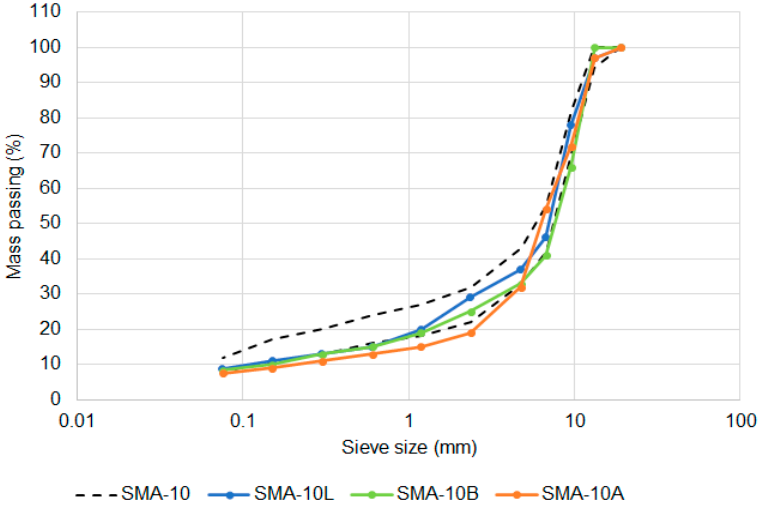
Figure 5. SMA-10 gradations compared to target.